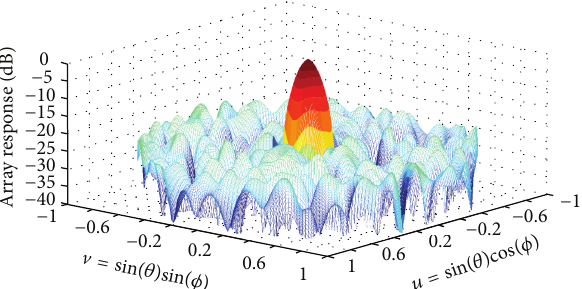
Figure 10: Three-dimensional radiation pattern for 136 elements’ antenna array given in Figure